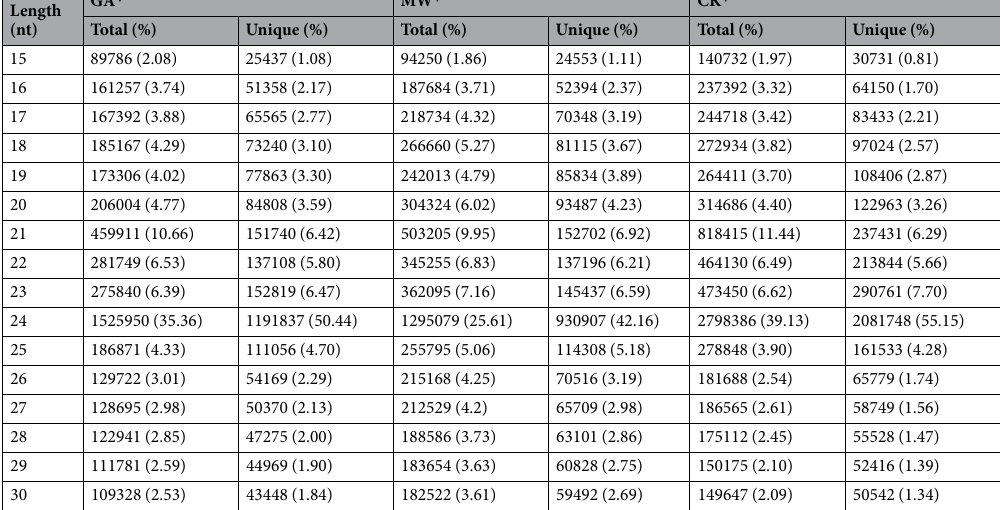
Table 2. Length distribution and abundances of small RNAs in the libraries of geometrid-attacked, mechanical- wounding and control samples from Camellia sinensis . * GA: geometrid-attacked, MW: mechanical-wounding, CK: control.